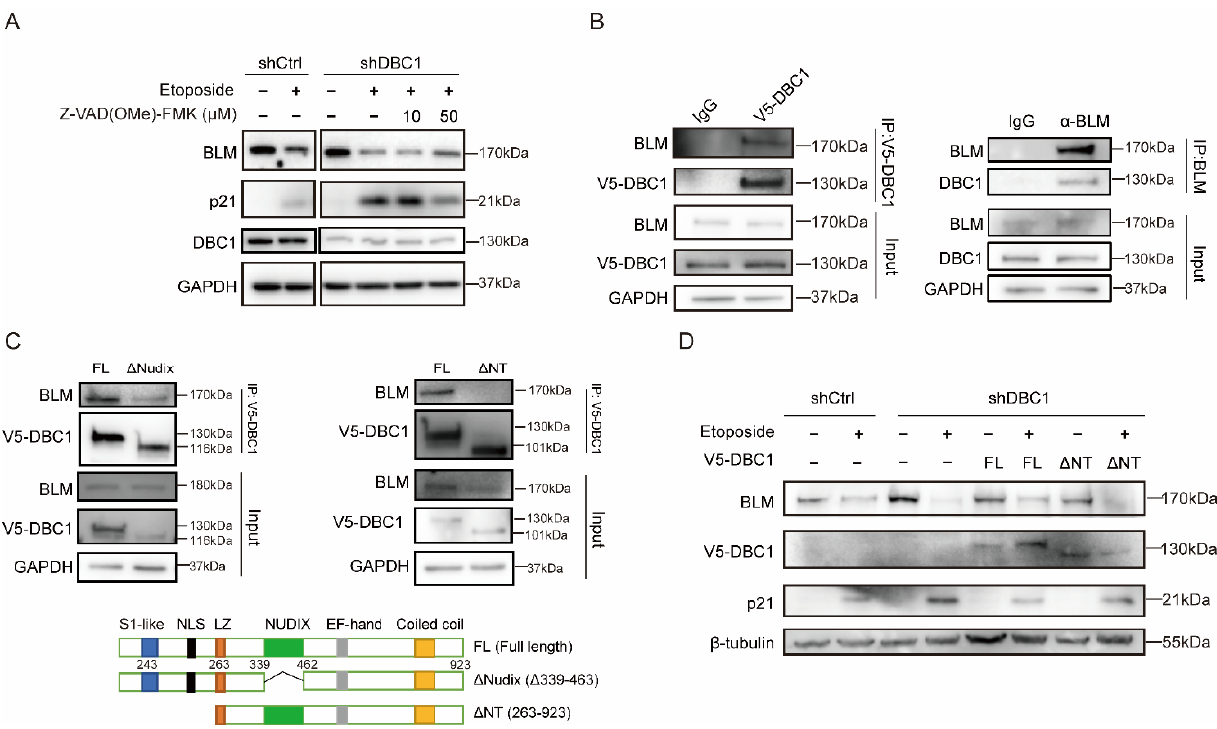
Figure 4. DBC1 binds to BLM to prevent its degradation. ( A ) Western blotting analysis of BLM and p21 protein levels in DBC1 knockdown cells treated with etoposide (100 μM) or Z-VAD-FMK for 24 h. ( B ) The reciprocal co-IP analysis on DBC1 and BLM interaction. ( C ) Co-IP of the full-length or truncated DBC1 with BLM. Schematic structures of full-length and truncated mutants of DBC1 are shown at the bottom. FL represents full-length; ΔNudix represents deletion of the Nudix domain (residues 339–463); ΔNT represents deletion of the N-terminal domain (residues 1–263). ( D ) Western blotting analysis of BLM and p21 protein levels in DBC1 knockdown cells with the reintroduction of the full-length or N-terminal truncated mutant DBC1 (ΔNT) after etoposide-induced DNA damage (50 μM, 24 h).